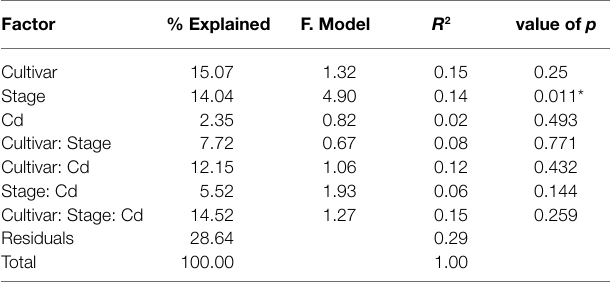
TABLE 1 | Permutational multivariate analysis of variance (PERMANOVA) results using weighted UniFrac distance matrices show effects of rice developmental stage, cultivar, and root Cd content on the bacterial community